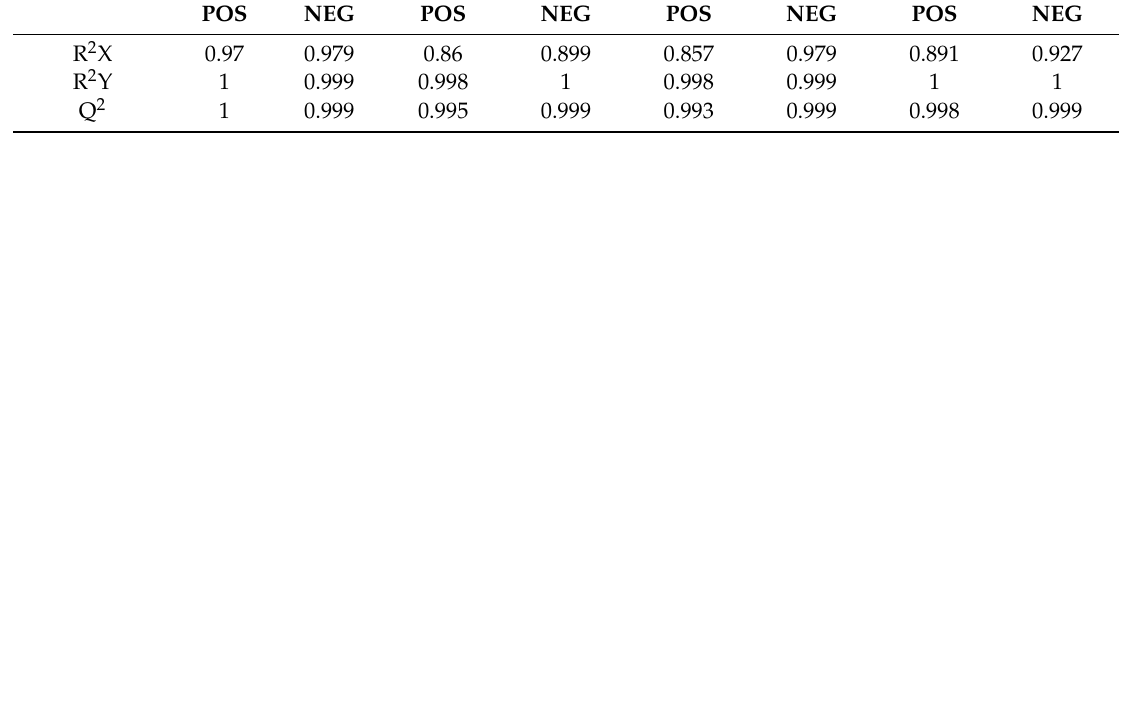
Table 1. R 2 X, R 2 Y and Q 2 values of PLS-DA in both positive and negative modes.